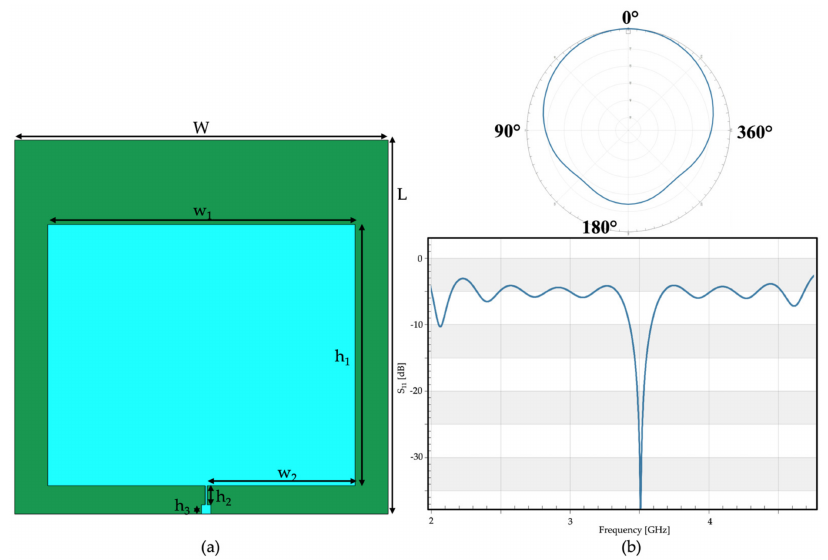
Figure 1. First wearable patch antenna simulated, tuned to f = 3.5 GHz: ( a ) geometry of the antenna, front view; ( b ) performances of the antenna in terms of, in the upper part, radiation pattern ( ϕ = 0 ◦ ), and, in the lower part, the reflection coefficient (S 11 ).